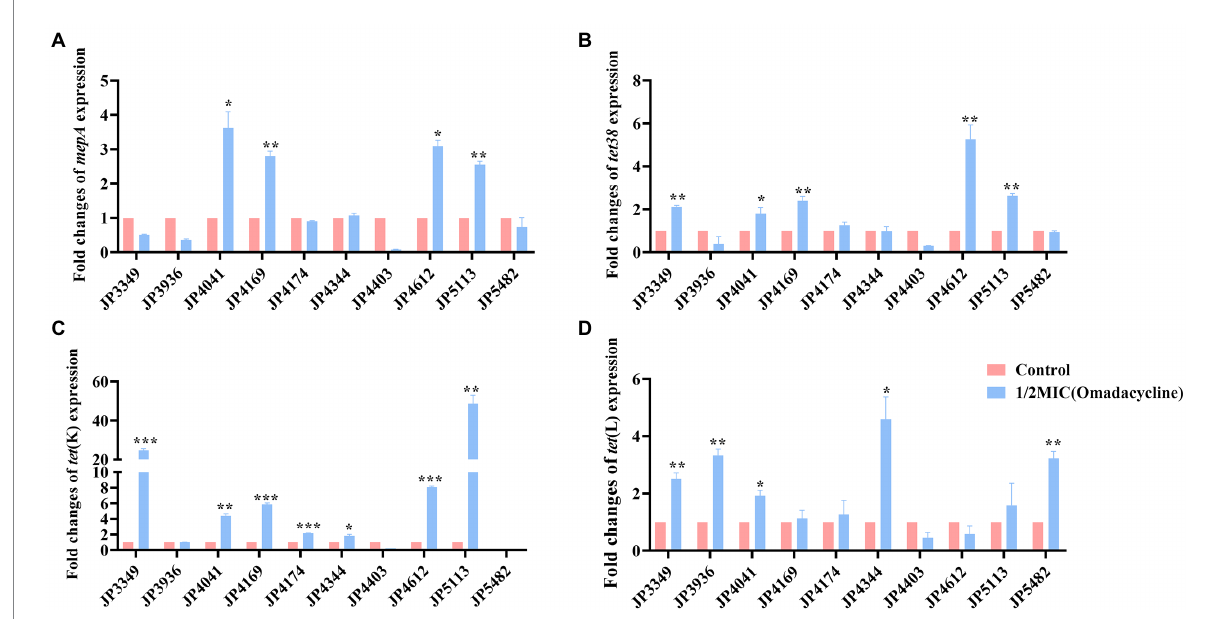
FIGURE 3 Fold changes in the expression of efflux pump-encoding genes in omadacycline-resistant Staphylococcus aureus exposed to 1/2 × MIC omadacycline concentrations. (A–D) The expression levels of mepA , tet38 , tet (K), and tet (L) genes. The values were normalized based on the internal control gene, gyrB . Data from the resistant strain with untreated 1/2 × MIC omadacycline were normalized to 1 to allow the comparison of data across different samples. Data represented the mean values from 3 independent experiments with error bars indicating standard deviations, and asterisks denoted the significance of differences in the expression by paired Student’s t -test (* p < 0.05; ** p < 0.01; *** p <